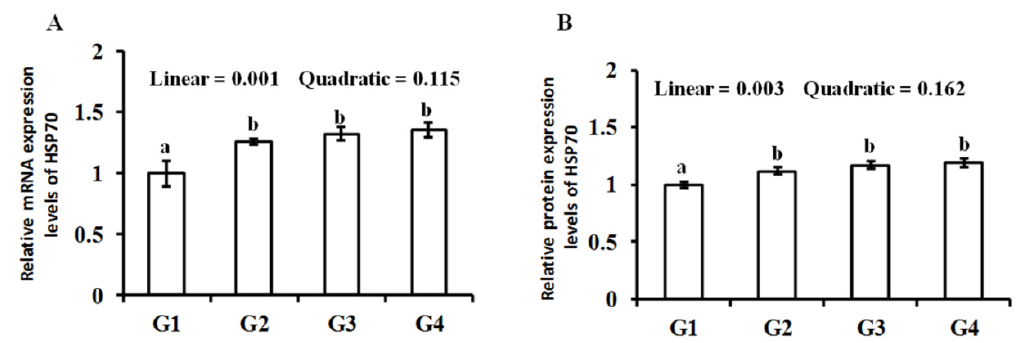
Figure 3. Effect of Gln on HSP70 gene ( A ) and protein ( B ) expression of the breast muscle in heat-stressed broilers. a, b: Values in columns with different letters differ significantly ( p < 0.05). Broilers in the G1, G2, G3, and G4 groups were housed in the hot environment and fed the basal diet with 0%, 0.5%, 1.0%, and 1.5% Gln, respectively.